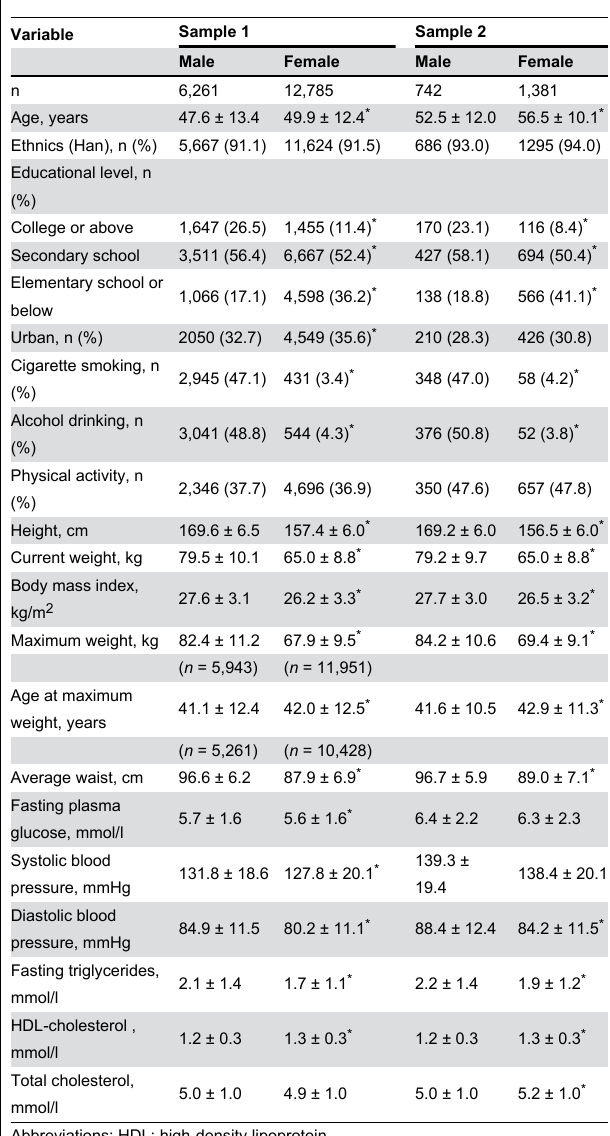
Table 1. Characteristics of sample 1 and 2 according to